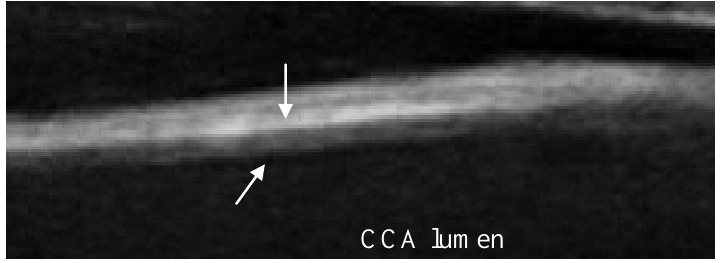
Figure 5. A sub-image in the near wall. There are some noises under the intima resulting difficulties in detection. The oblique arrow indicates the intima and the vertical arrow indicates the outer wall of the CA. (Sequence